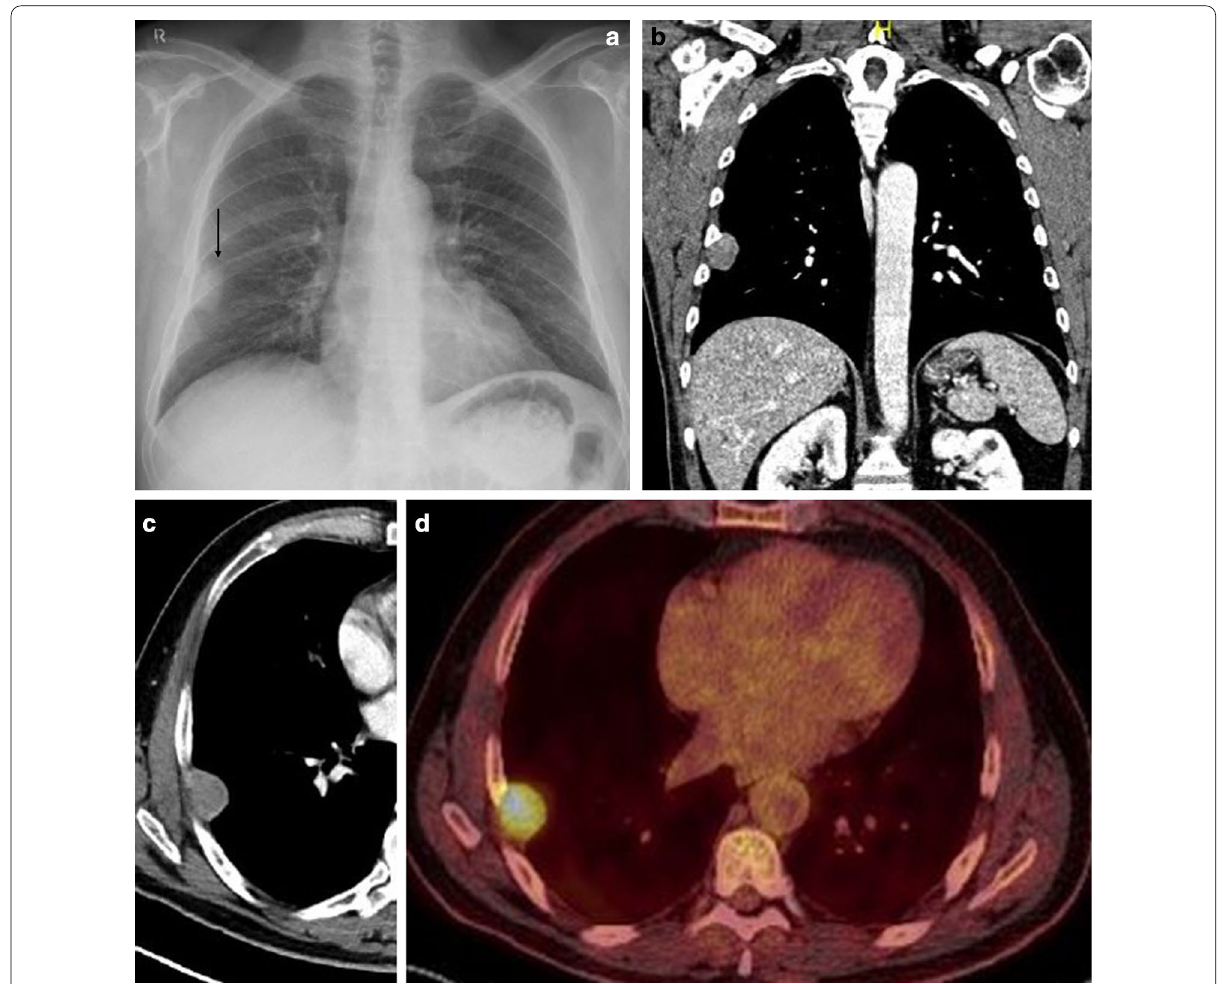
Fig. 15 Diagnosis: schwannoma. Technique: standard chest radiography, contrast-enhanced chest CT and 18FDG-PET CT. Description: A 55-year-old man with no significant medical history was referred for a chest radiograph because of a persistent cough. As an incidental finding, a sharp delineated mass (arrow) laterally in the right hemithorax was found on the postero-anterior chest radiograph ( a ). Coronal and axial CT images ( b , c ) in the mediastinal window setting reveal a small homogeneous lesion located intercostally between the 5th and 6th right ribs. The lesion shows high uptake on 18-F-FDG PET ( d ). Although the high uptake on PET may mislead to a malignant cause, histopathologic examination of the resected specimen confirmed the suggested diagnosis of a